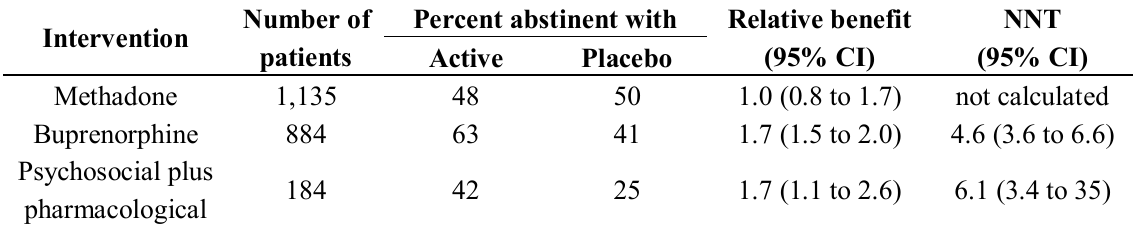
Table 6. Results of opioid cessation reviews, ordered by number of participants. The order is by numbers of participants in the reviews. Intervention is as described in each review, and details of the reviews is in Table